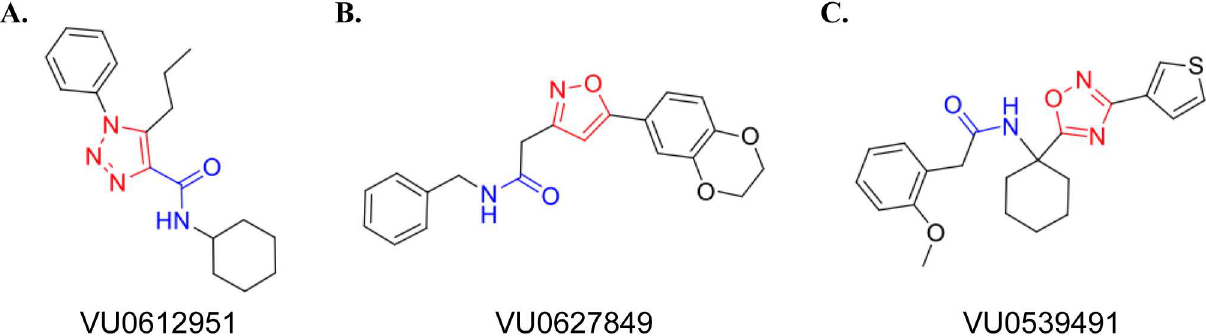
Fig 6. Chemical structures of our candidate hits. (A) Structure of VU0612951 highlightingthe 1,3-triazolegroup in red. (B) Structure of VU0627849 highlightingthe isoxazolegroup in red. (C) Structure of VU0539491 highlightingthe 1,2,4-oxadiazolegroup in red.